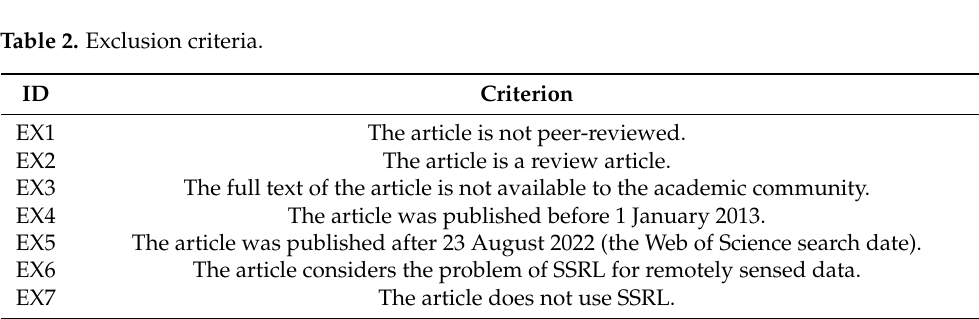
Table 2. Exclusion